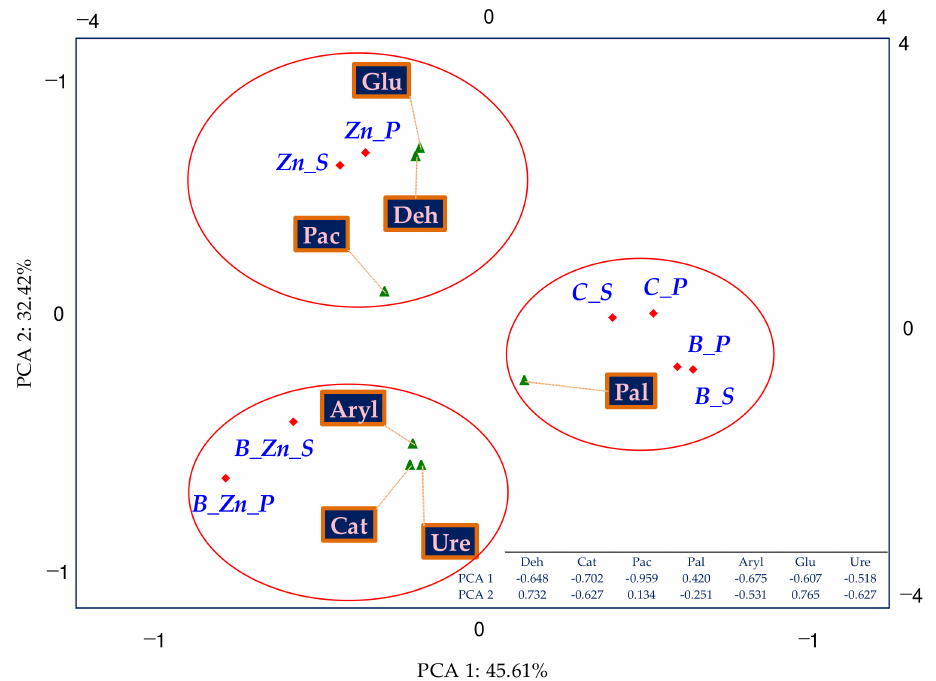
Figure 3. The coefficient of the influence of plants (IF P ) on the activity of dehydrogenases (Deh), catalase (Cat), urease (Ure), acid phosphatase (Pac), alkaline phosphatase (Pal), arylsulfatase (Aryl), and β -glucosidase (Glu) in uncontaminated and contaminated soil B, Zn 2+ , and B + Zn 2+ —PCA method; S— Sorghum Moench (S) and P— Panicum virgatum , C—uncontaminated soil, B—bisphenol A, Zn—ion zinc (Zn 2+ ).